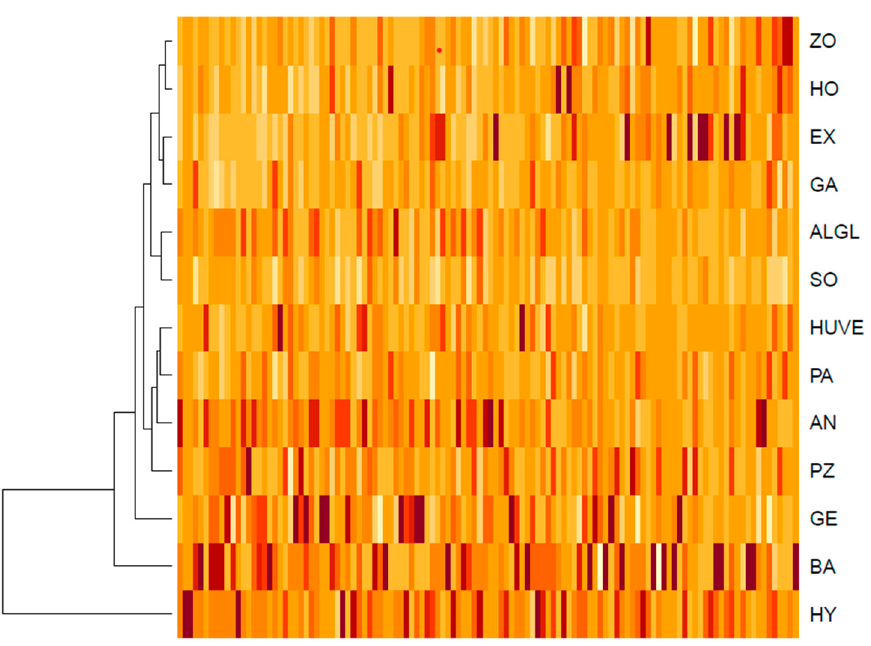
Figure 4. Relative concentrations of 118 mass peaks among 13 Mortierella s. l. species observed in this study. All mass peak concentrations illustrated differ significantly between species (p Kruskal < 0.05). For illustration, the concentrations were centered and scaled by columns. Consequently, color shades can be compared between species but not between mass peaks. Darker colors indicate higher and lighter colors indicate lower concentrations. ALGL = M. alpina/globalpina , AN = M. angusta , BA = M. bainieri , EX = L. exigua , GA = L. gamsii , GE = M. gemmifera , HO = P. horticola , HUVE = P. humilis/verticillata , HY = L. hyalina , PA = E. parvispora , PZ = M. pseudozygospora , SO = M. solitaria , ZO = M. zonata .